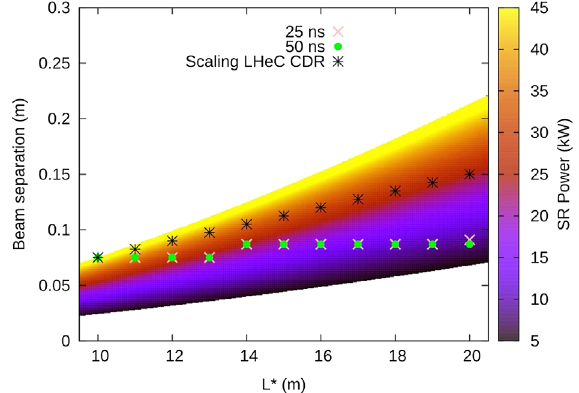
FIG. 14. Comparison between DA of beam 1 and beam 2 for the round optics of the HLLHCV1.0 version of the HL-LHC 15 cm and β 10 m) without errors for experiment ( β IP 1 ; 5 ¼ IP 2 ¼ IT, Q4, Q5, D1 and D2 of IR1 and IR5.